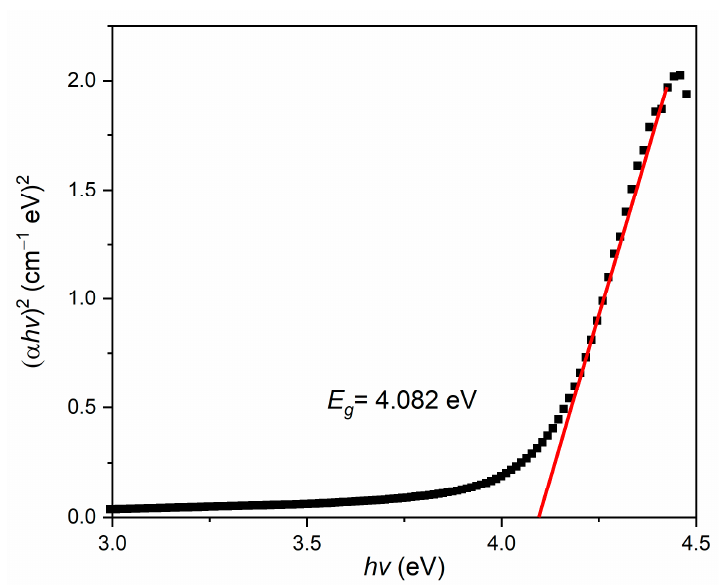
Figure 8. Energy band gap of the NCC/PEDOT thin film.